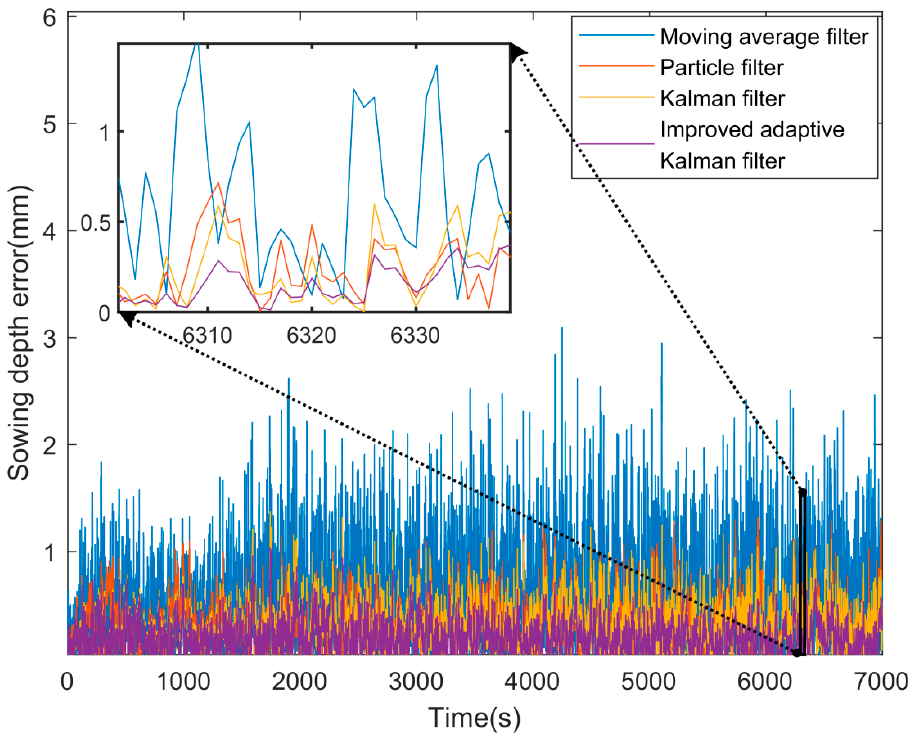
Figure 14. Error variation of the sowing monomer experiment. Table 2. Sowing depth measurement MSE.